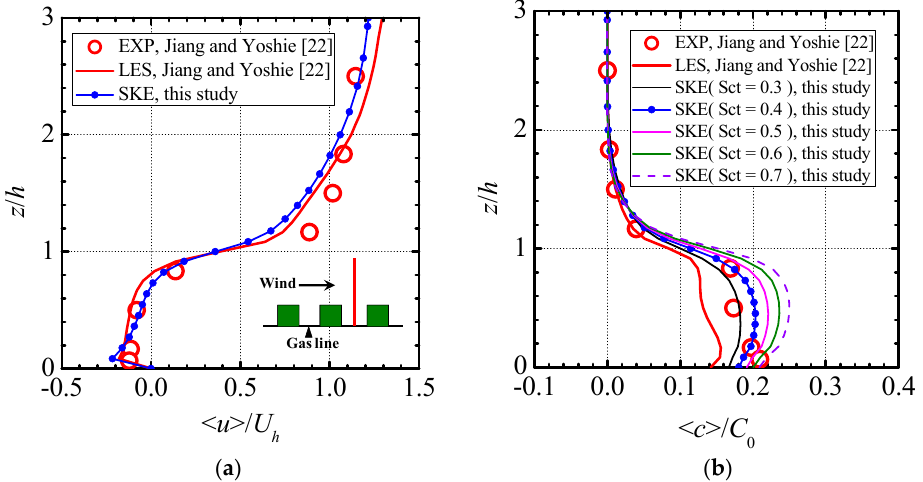
Figure 2. Vertical distributions of mean flow variables: ( a ) normalized mean streamwise velocity; ( b ) normalized mean concentration.